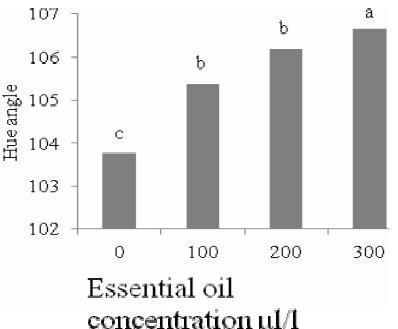
Fig. 9. The effect of basil essential oil treatment on hue angle of ‘Golden Drop’ plum Note: All data in figure are the mean of measurement hue angle in all sampling